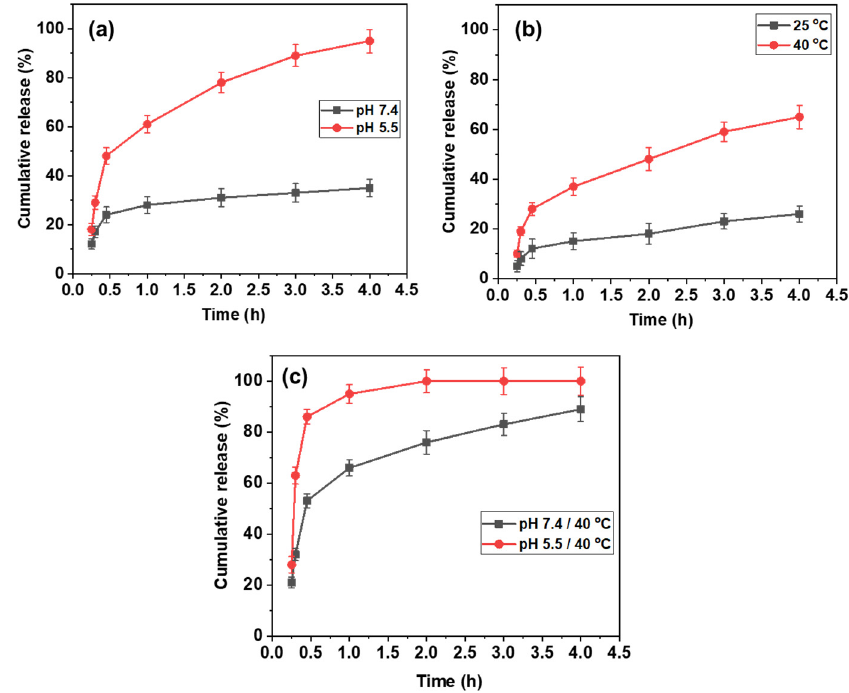
Figure 5. In vitro Cur delivery of PNIPAm-co-PAAm@Cur HG system. ( a ) Cur release with pH stimulus, ( b ) Cur release with temperature stimulus, and ( c ) Cur release with pH and temperature stimulus.